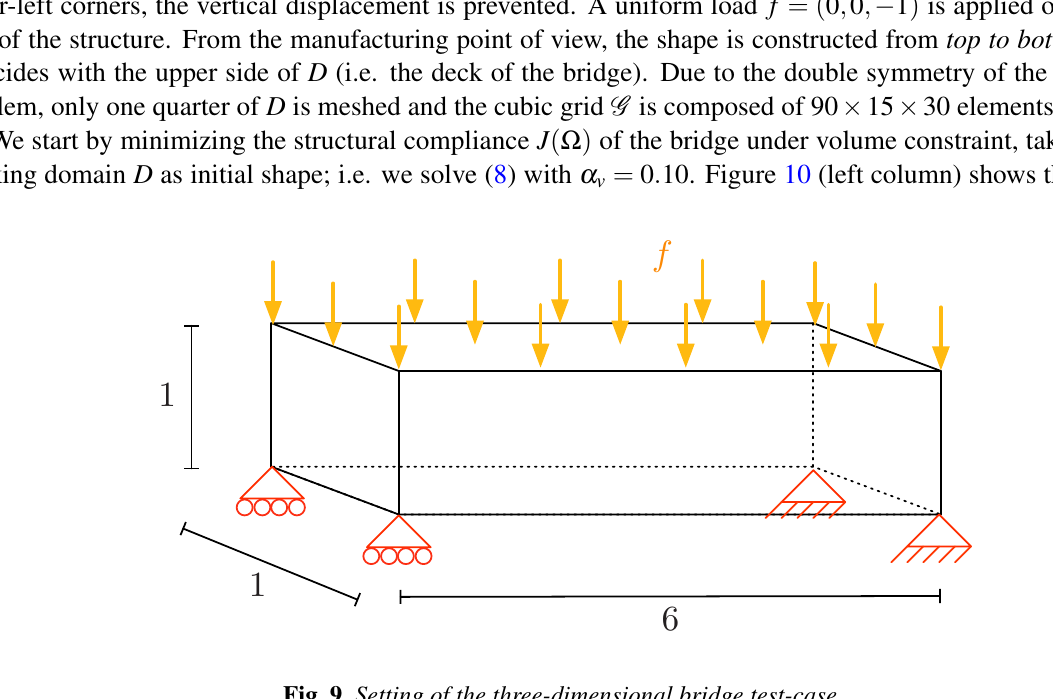
Fig. 9 Setting of the three-dimensional bridge